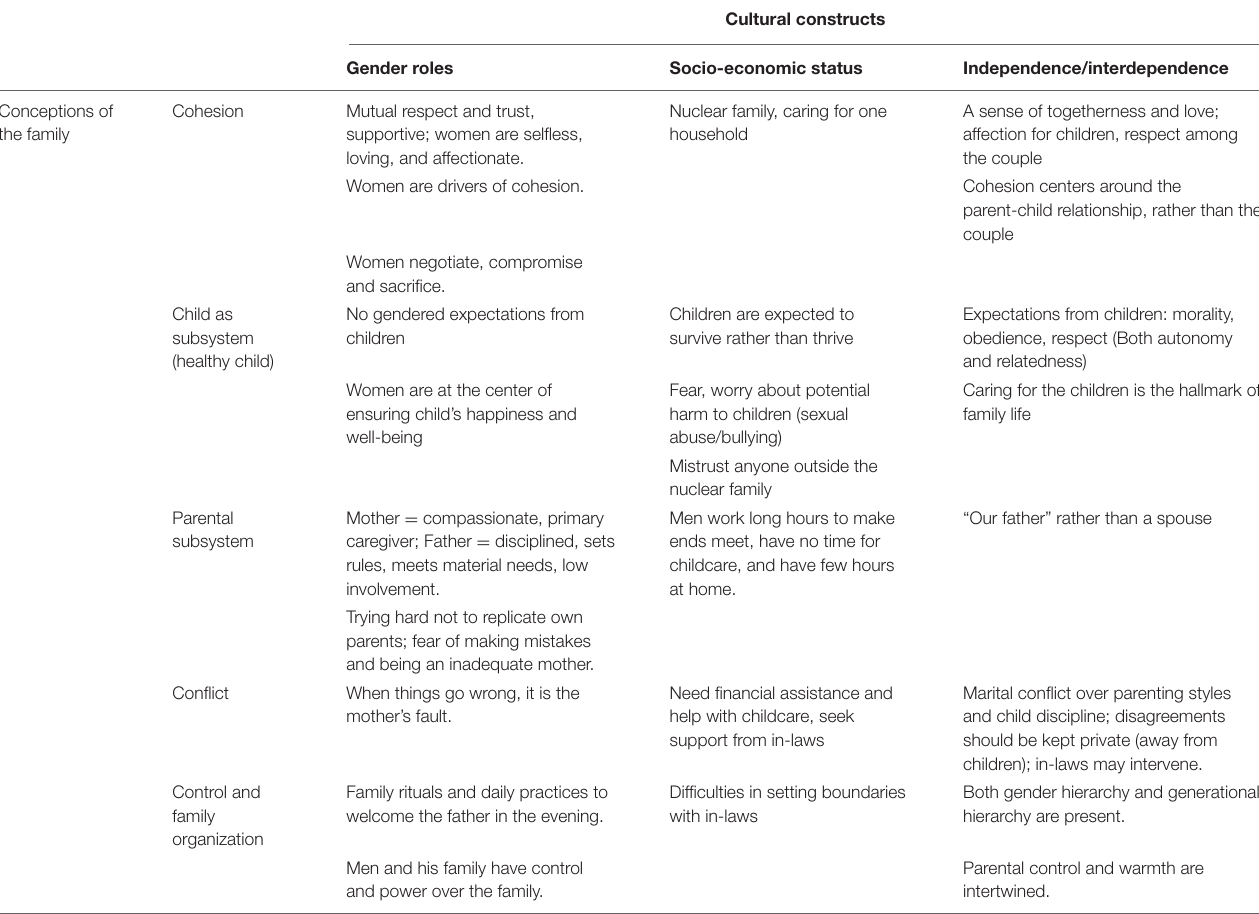
TABLE 3 | Summary of findings: Women’s conceptions of the family by cultural